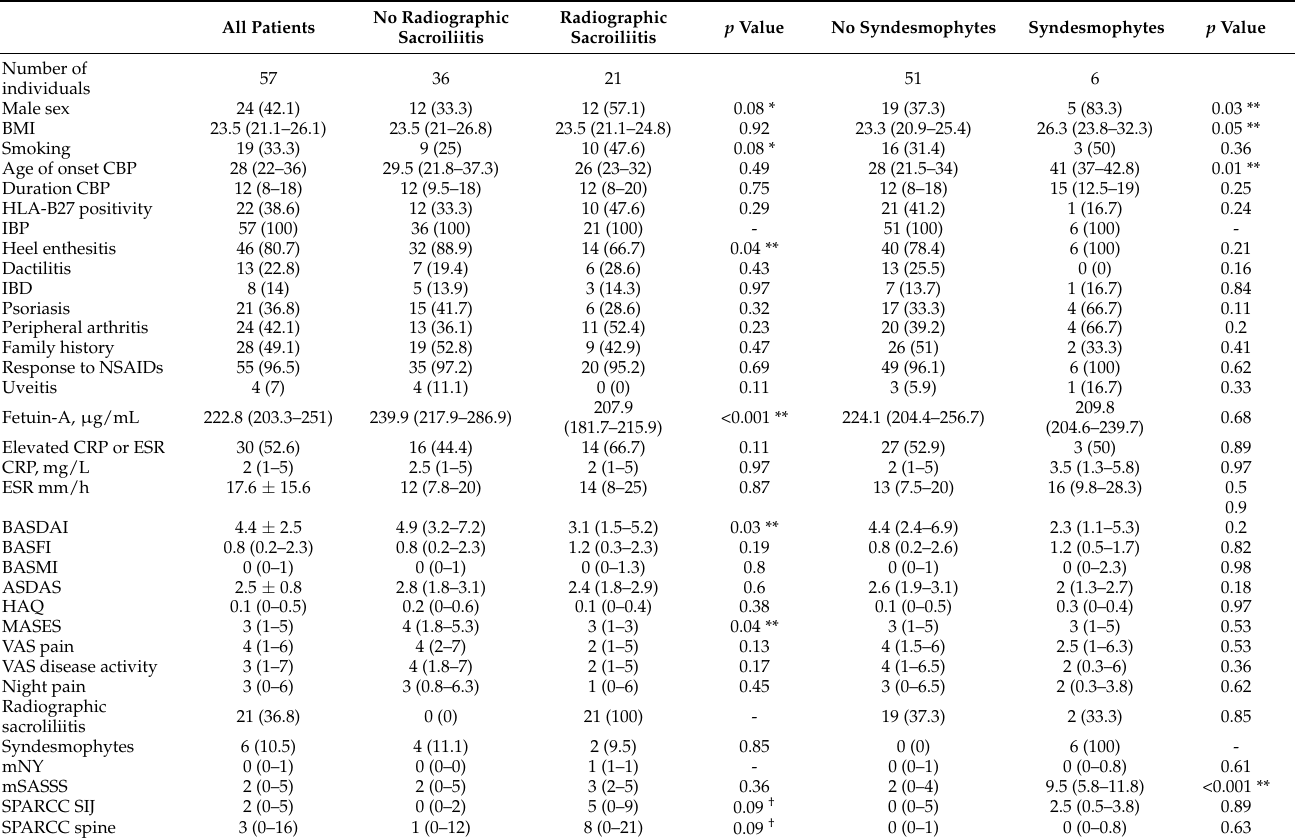
Table 1. Characteristics of the patients in the entire cohort at T0 ( n = 57), and according to the presence of radiographic sacroiliitis and syndesmophytes, results of univariate